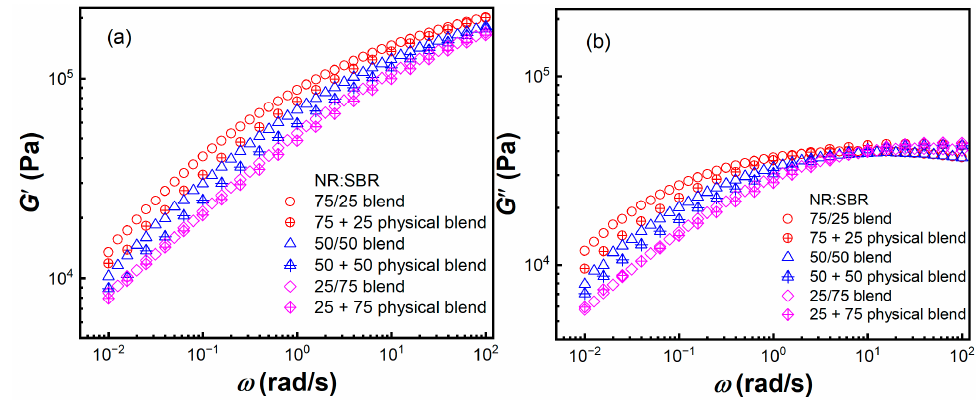
Figure 5. ( a ) Storage moduli G ′ and ( b ) loss moduli G ′′ as a function of frequency ω at γ = 0.5% and 100 °C for the NR/SBR blends and NR + SBR physical blends.